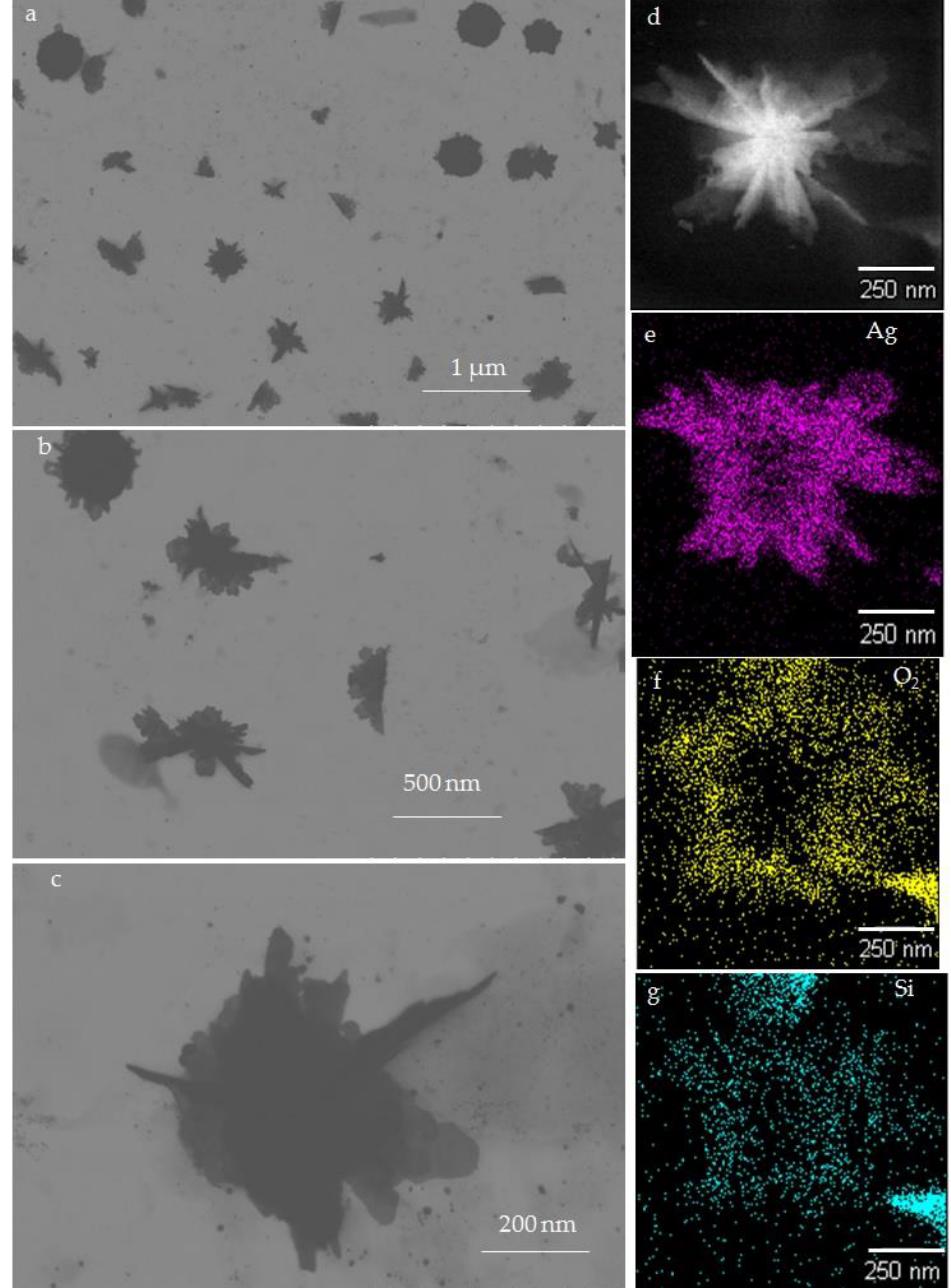
Figure 8. TEM images of flower shaped Ag-SiO 2 nanohybrid synthesized by G. flavovirens in different magnifications ( a – c ). EDS mapping ( d – g ) showing the distribution pattern of Ag, Si and O 2 in all over the Ag-SiO 2